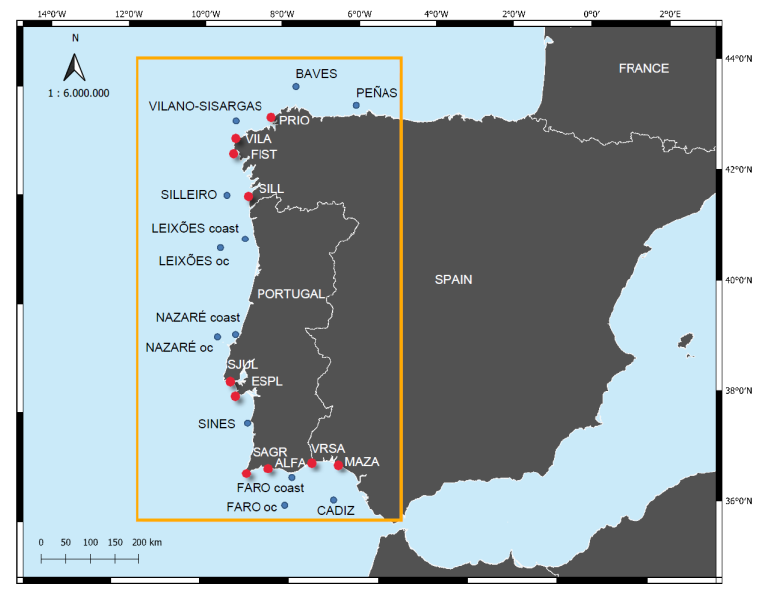
Figure 1. Study area—Western Iberian Peninsula. Blue dots: wave buoy positions; red dots: high-frequency radars (HFR)’s site location; orange rectangle: the study area.